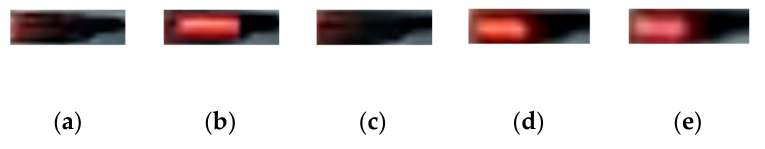
Figure 20. On and off process change chart of the direction light.